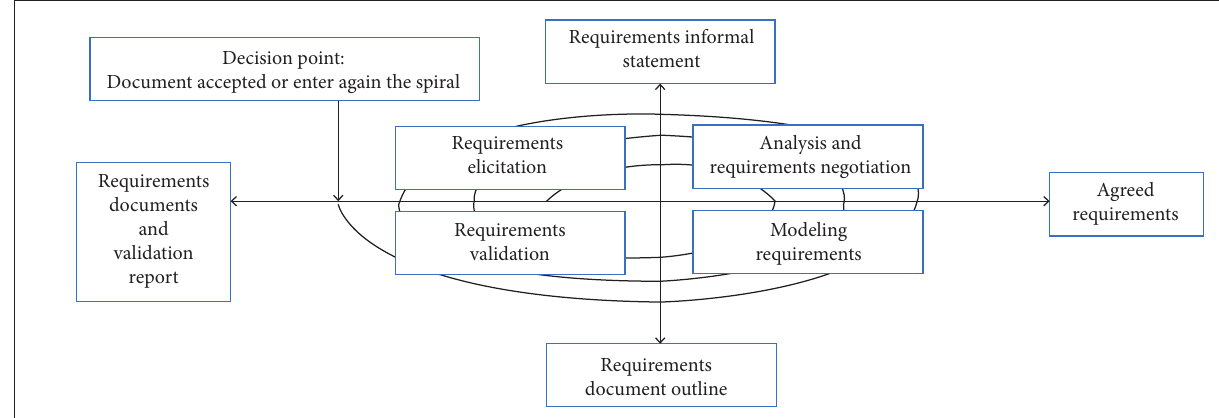
Figure 1. Spiral Engineering Requirements process (Alves